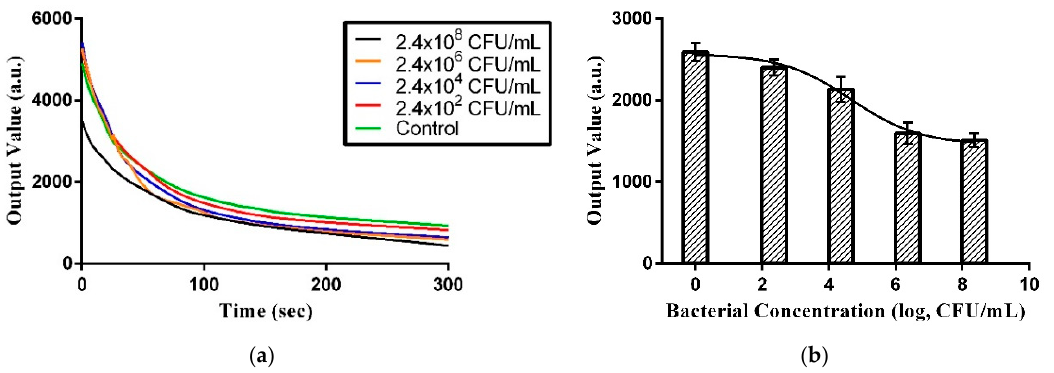
Figure 5. ( a ) Measurement changes over time demonstrating the output values of bacterial samples of different concentrations. ( b ) Prediction model for bacterial concentration using PBS and 5 min colorimetric values.